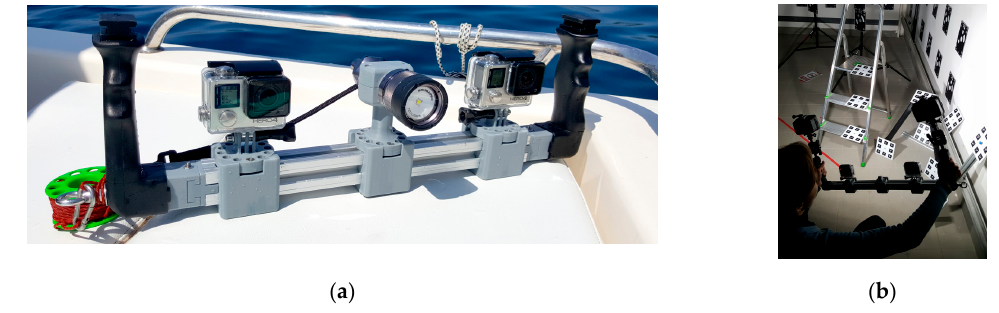
Figure 16. Example of the stereo camera rig mounting two GoPro Hero4 Black Edition in their pressure housings ( a ) and during a pre calibration in the laboratory in the same setup used for Grotta Giusti (underwater lights on the two handles) ( b ).